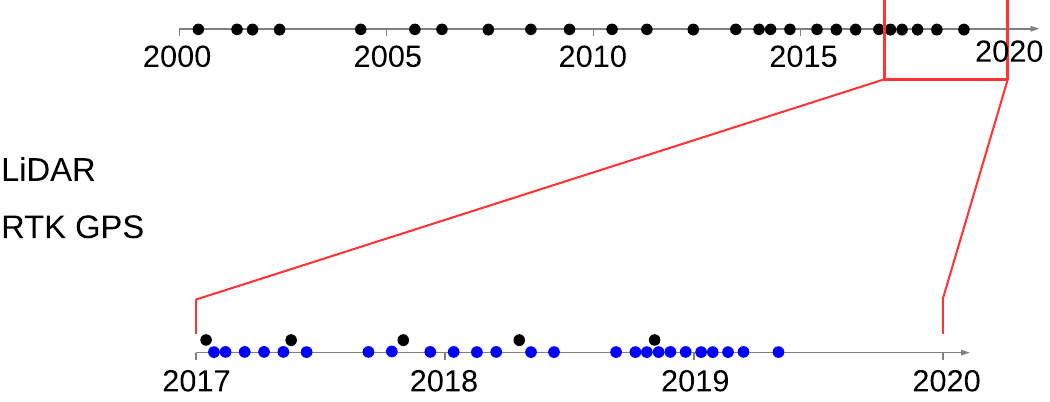
Figure 3. Timeline of the monitoring surveys used in this study. Top: LiDAR surveys since 2000. Bottom: detail of the timeline with RTK GPS (blue) and LiDAR (black) surveys since